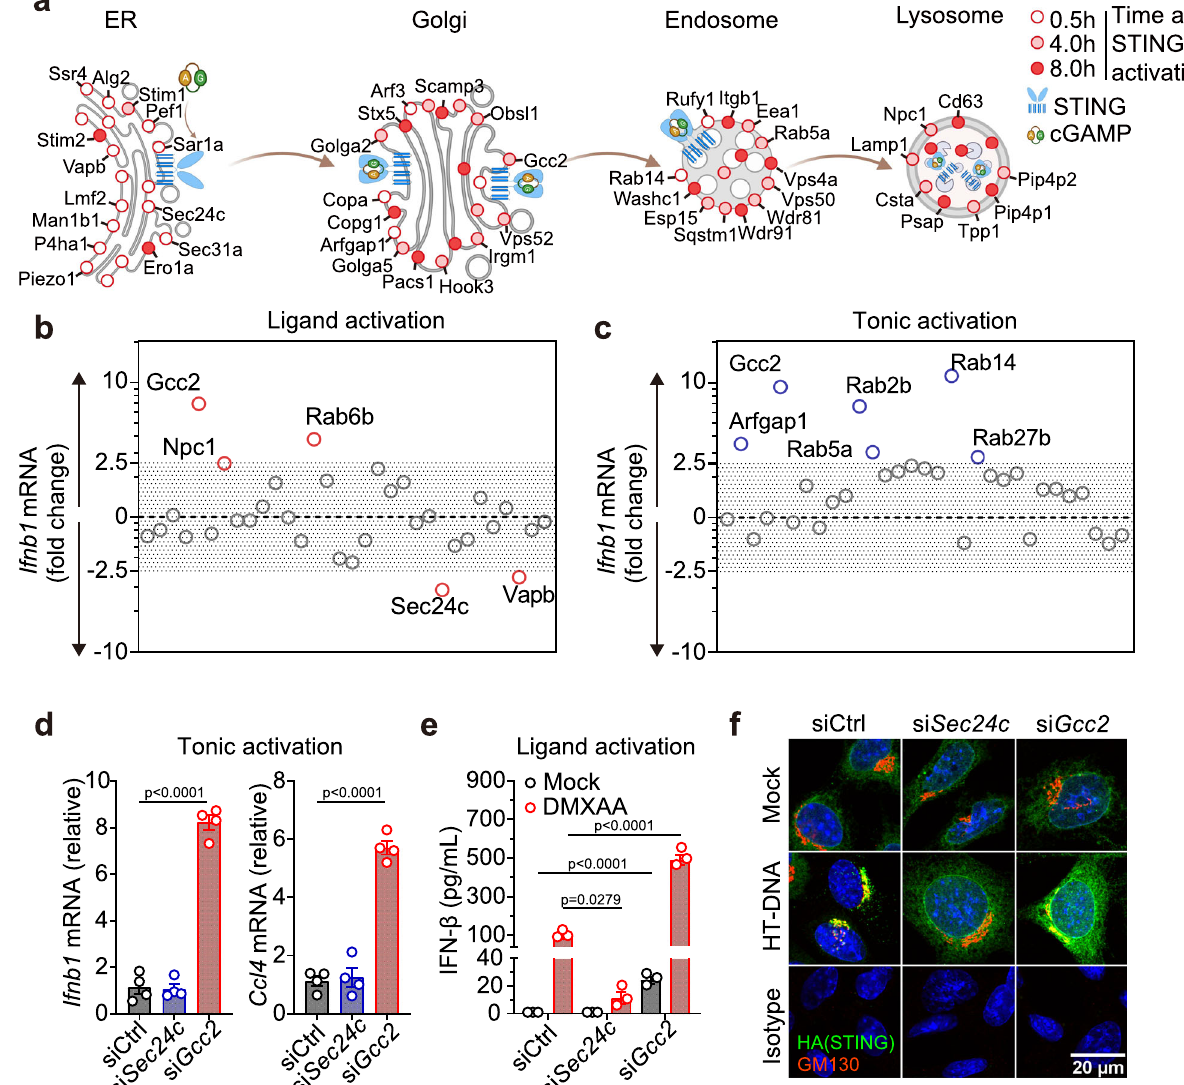
Fig.1|KnockdownofSTINGpost-GolgicofactorsactivatestonicIFNsignaling. a A spatiotemporal map of selected STING cofactor candidates identi fi ed in